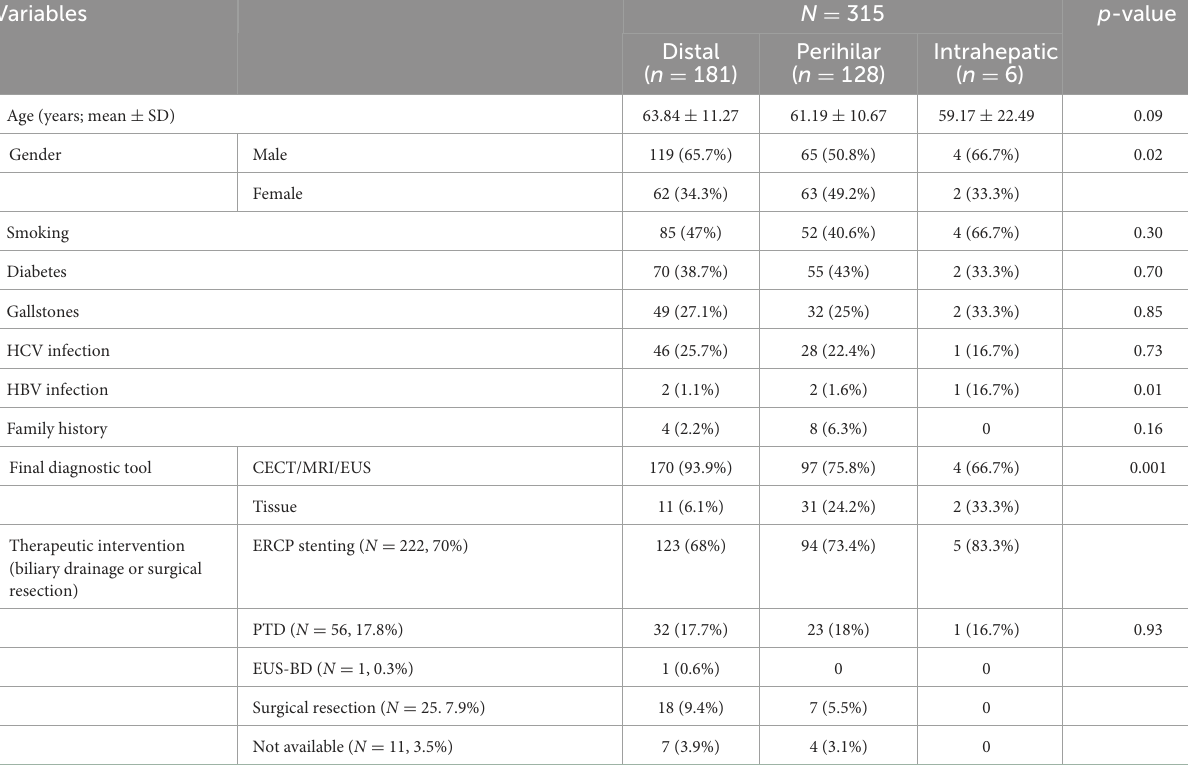
TABLE 3 Distribution of different variables according to the anatomical location of biliary stricture ( n = 315).